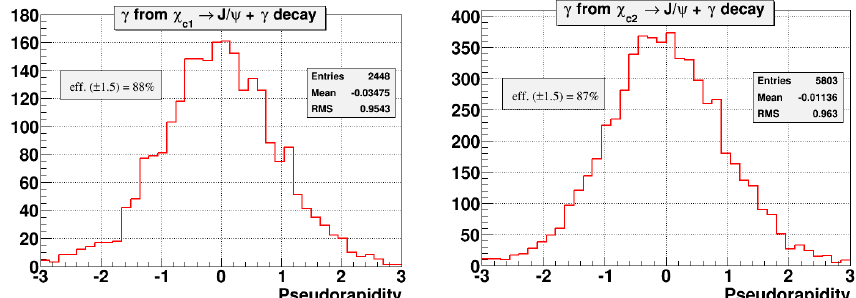
Figure 2 . Pseudorapidity distributions of the photons from charmonia decays: left) χ c1 , right) χ c2